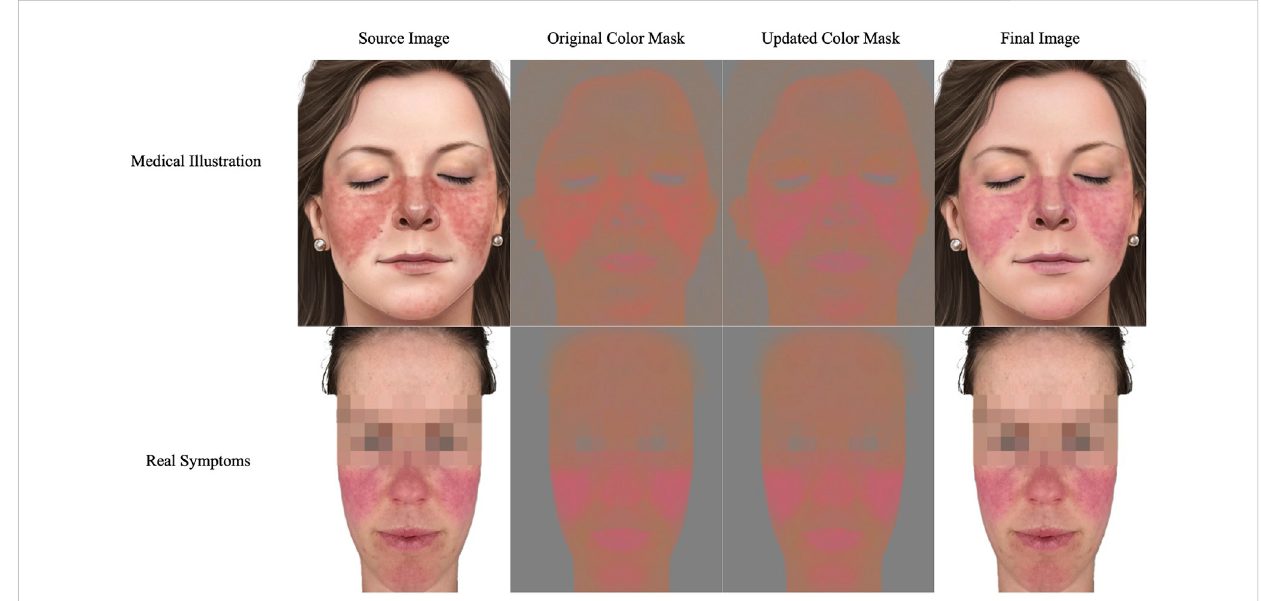
FIGURE 3 Source image for the medical illustration fi lter (top left) was manipulated using color masks to better match the real symptom image (bottom left) (Lupus Trust, 2021; Mayo Clinic Staff, 2021). The third column shows the medical illustrationafter replacing colors. The fi nal row depicts the images used to generate the AR fi lters.